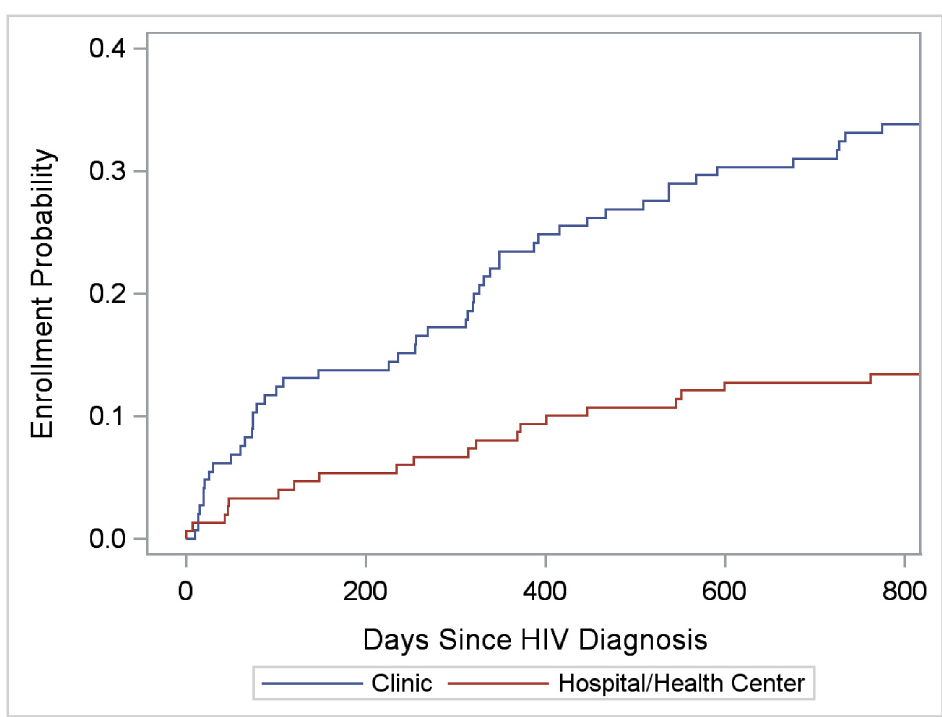
Fig 7. Cumulative verified enrollment in HIV care, by type of health facility, SHIMS male clients only. Log-rank test for differences in functions = 18.47; P <